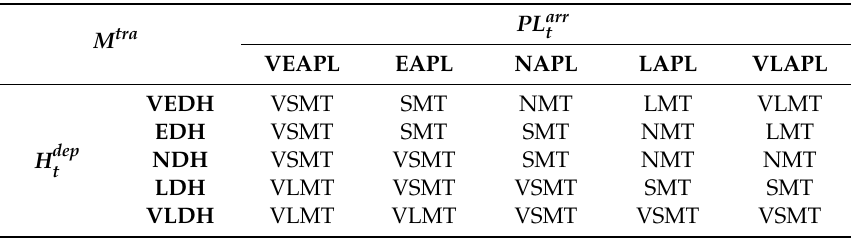
Figure 4. Membership functions of the fuzzified input and output variables for first stage FIS: ( a ) Membership functions of departure time from home; ( b ) Membership functions of arrival time to PL; ( c ) Membership functions of mileage traveled. Table 1. Set of fuzzy rules of first stage FIS for computing the traveled